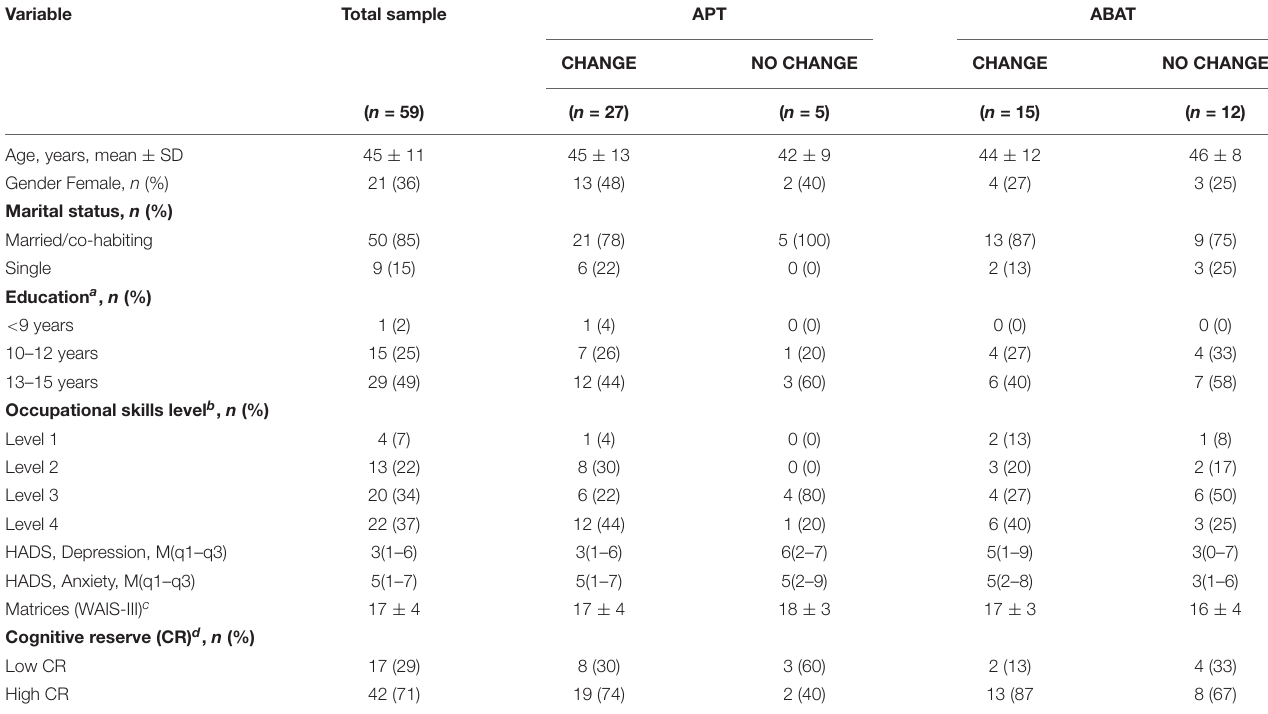
TABLE 1 | Demographical characteristics of participants at baseline assessment according to the type of treatment and treatment outcome (CHANGE/NO CHANGE). Variable Total sample